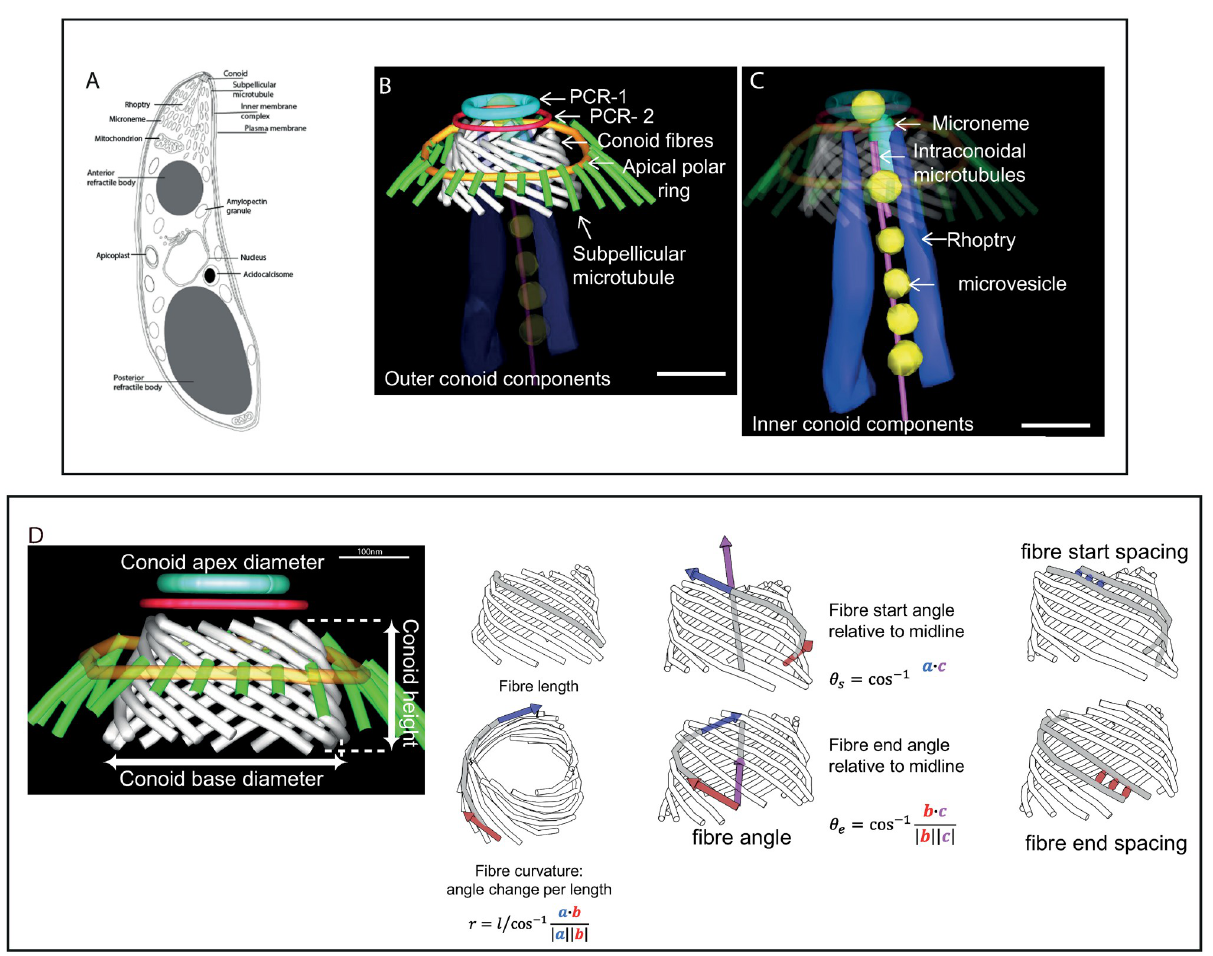
Fig 1. Components of the apical complex in sporozoites of E . tenella . A: cartoon overview of Eimeria tenella ultrastructure. The apical complex is divided into outer conoid (B) and inner conoid (C) components. B and C: Segmentation from a serial section dual axis tomogram. Outer conoid components; conoid fibres (white); 2 pre-conoidal rings (PCR 1 and 2) (light blue and red), apical polar ring (gold) in association with sub-pellicular microtubules (green); B: Inner conoid components, rhoptry (dark blue), microneme (light green), microtubule-associated vesicles (MVs) (yellow), intra-conoidal microtubule pair (pink); Scale bars—200nm; D: Illustrations of measurements carried out of conoid features (n = 14 complete conoid tomograms). Conoid height, apex, and base diameter, fibre length, fibre curvature, fibre angle and fibre spacing. S1 Table contains the measurement data and statistics. Materials and methods describe how the measurements were carried